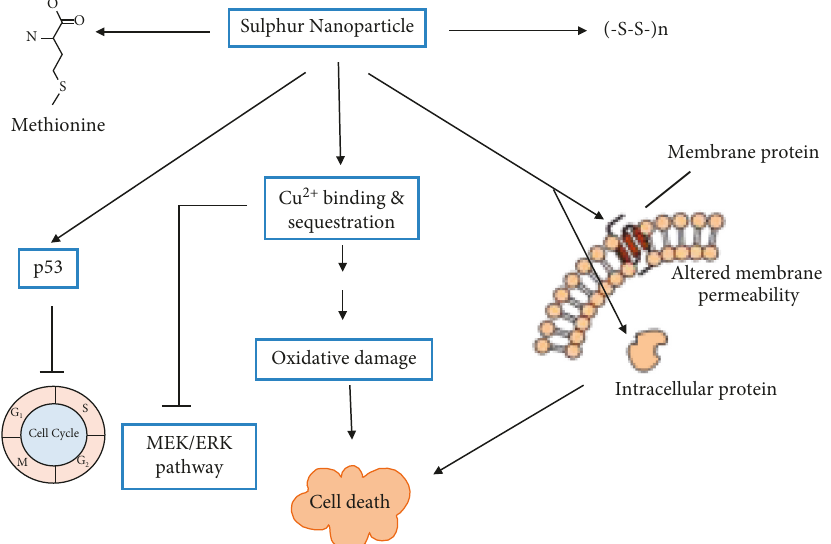
Figure 6: Anticancer mechanism of sulfur